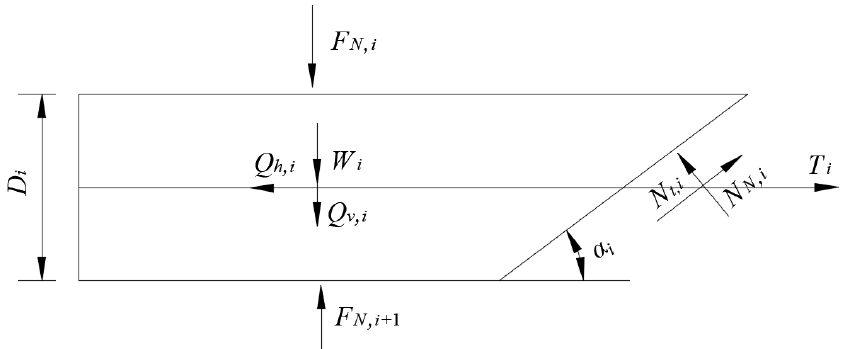
Figure 2. Forces acting on the i th slice (modified after Jia et al. 2018).